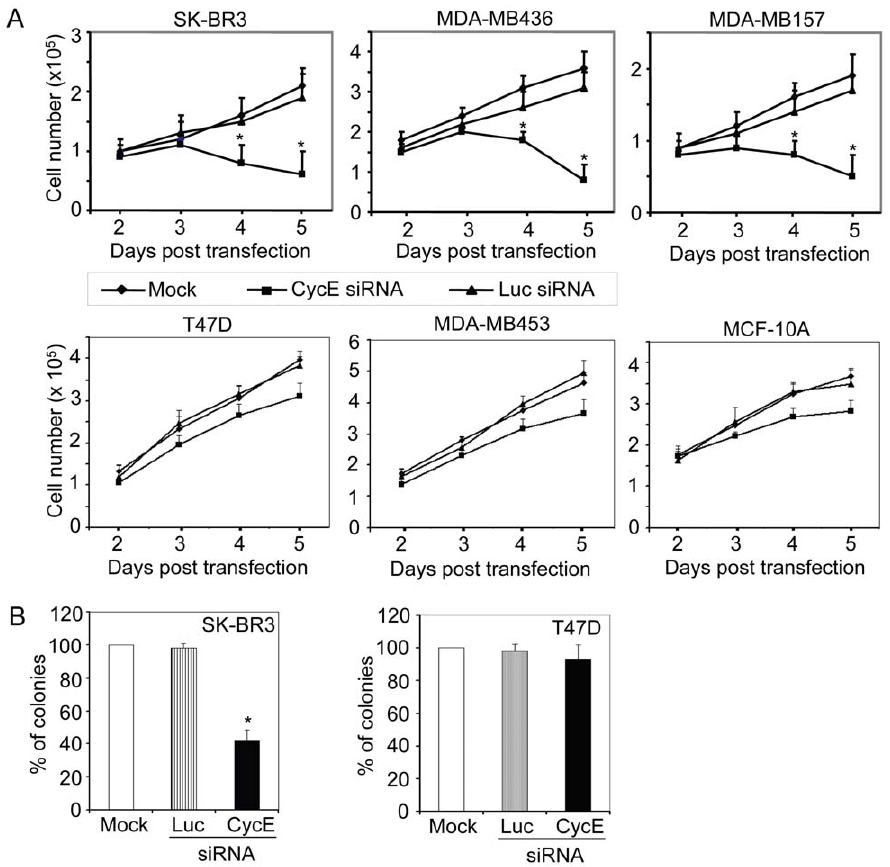
Figure 3. Inhibition of cell transformation by cycE siRNA invitro. A ) Growth curves of breast cancer and normal epithelial cells in response to cycE siRNA. The viable cells were counted at the indicated time points after transfection of siRNA oligos. The data shown here represent the averages from three independent experiments. B ) Suppression of colony formation in soft agar by cycE siRNA. The indicated cells were transfected with siRNA targeting on cyclin E (cycE) or luciferase (Luc) and then seeded in 0.35% agar containing DMEM with 10% FBS. The cells without any oligo transfection (mock) were used as a control. The cell viability for each group (mock, Luc, or cycE) was determined by colony formation assay. The number of colonies on soft agar was counted 3-5 weeks later and was normalized by their cell viability. The normalized number of colonies on soft agar for the groups of Luc or cycE was standardized against the control cells (mock, set at 100%) and indicated on the y axis. The data were the averages from two independent triplicate experiments. (*) p # 0.001 compared with